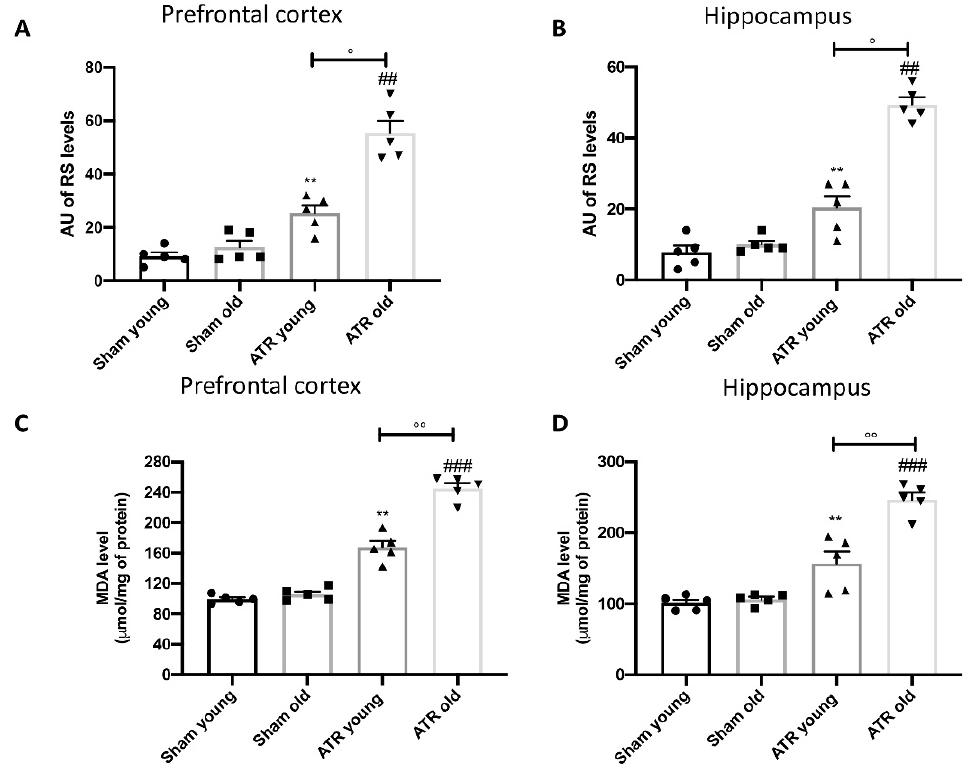
Figure 5. Effect of ATR inhalation on oxidative stress and lipid peroxidation. RS levels in prefrontal cortex ( A ); RS levels in hippocampus ( B ); MDA levels in prefrontal cortex ( C ); MDA levels in hippocampus ( D ). After ATR exposure, both young and aged mice showed a significant increase in RS production as well as in lipid peroxidation in prefrontal cortex and hippocampus. Statistical analysis reveal that aged mice were more susceptibility compared to young mice to develop RS and lipid peroxidation. Data is expressed as the mean ± SEM of n = 5 animals for each group. ** p < 0.01 vs. Sham young; ## p < 0.01 vs. Sham old; ### p < 0.001 vs. Sham old; ◦ p < 0.05 ATR old vs. ATR young; ◦◦ p < 0.01 ATR old vs. ATR young.